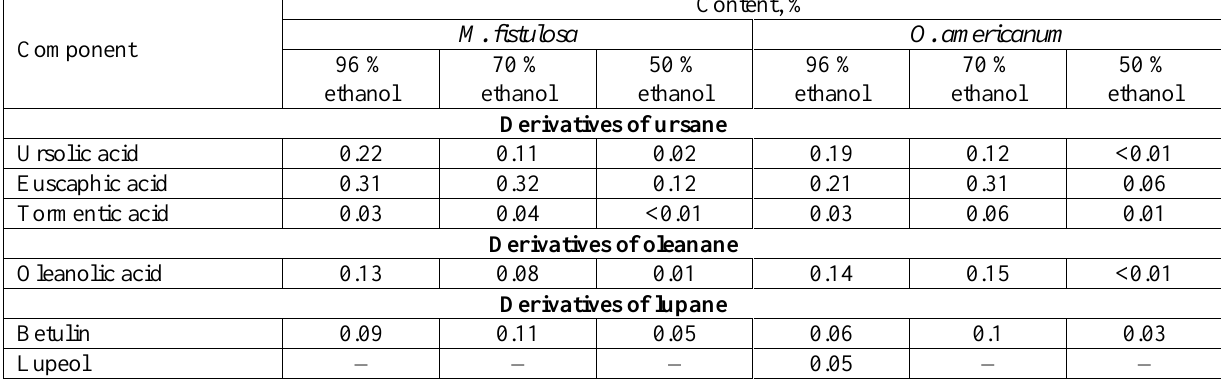
Component content of triterpene compounds in the aboveground parts of M. fistulosa and O. americanum